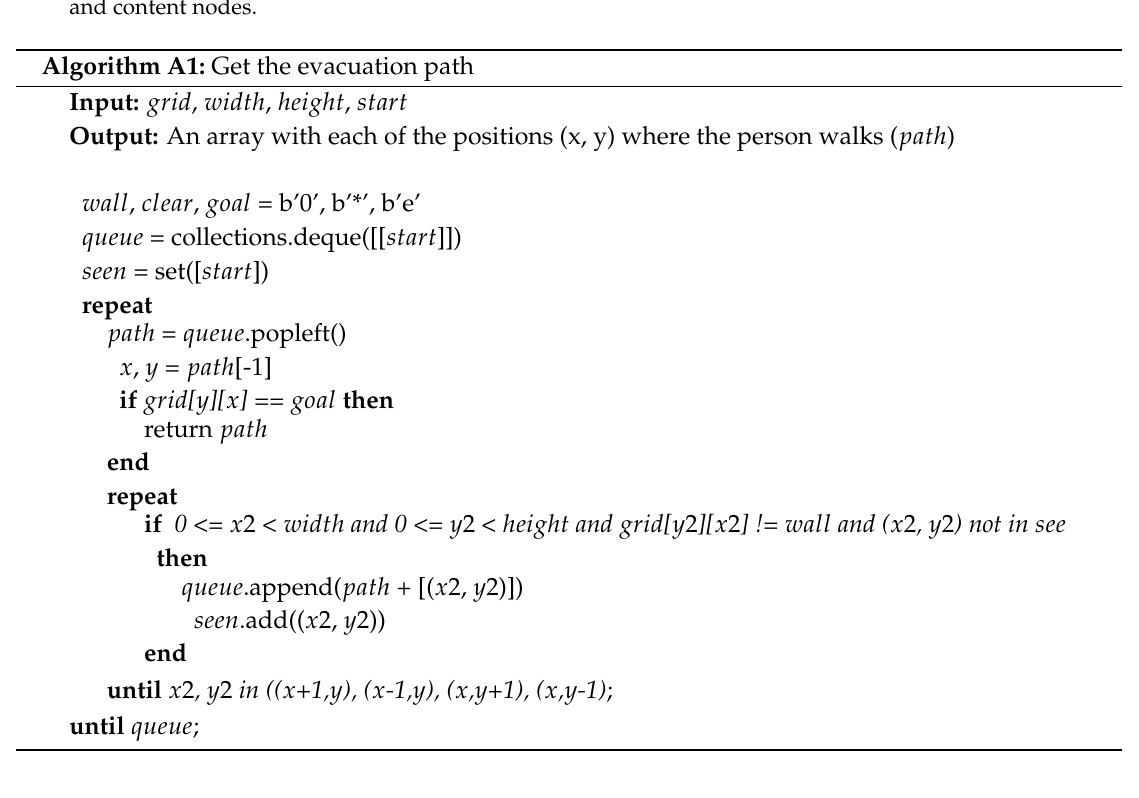
Figure A1. Model of the internal structure building, stored in a graph with their respective relationships and content